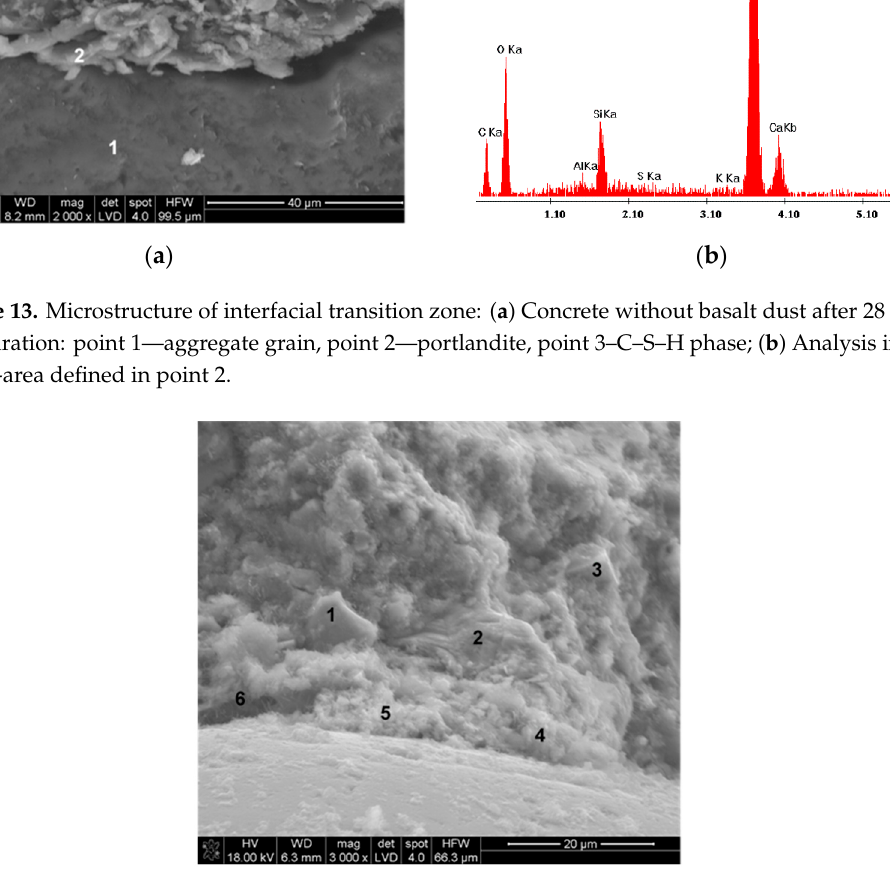
Figure 14. Microstructure of interfacial transition zone: concrete with 10% basalt dust addition after 28 days of hydration: point 1 and 3—basalt dust grain, point 2 and points 4-6—C–S–H phase.